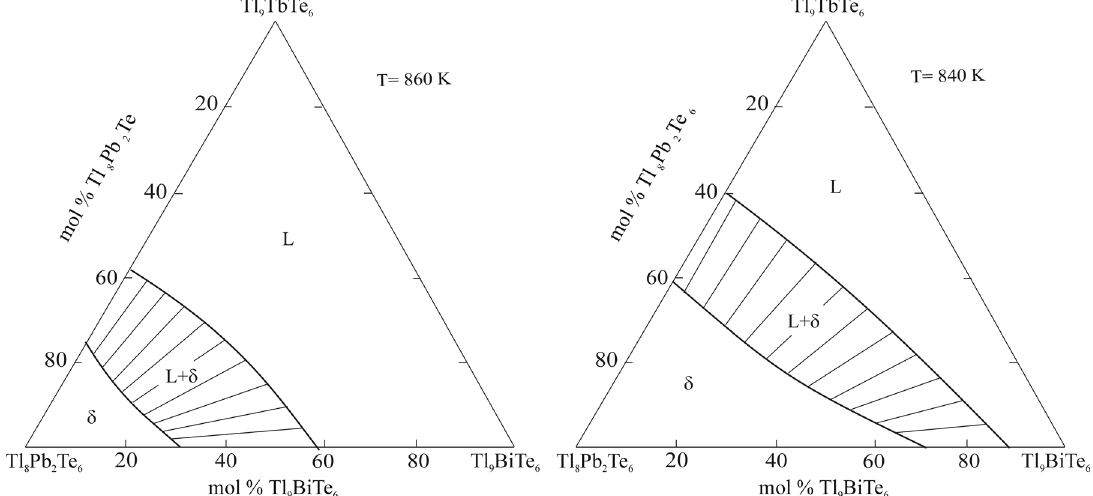
PbTe -Tl Tb -Tl BiTe section of the Tl-Pb-Bi-Tb-Te system. 4 3 9 6 9 6